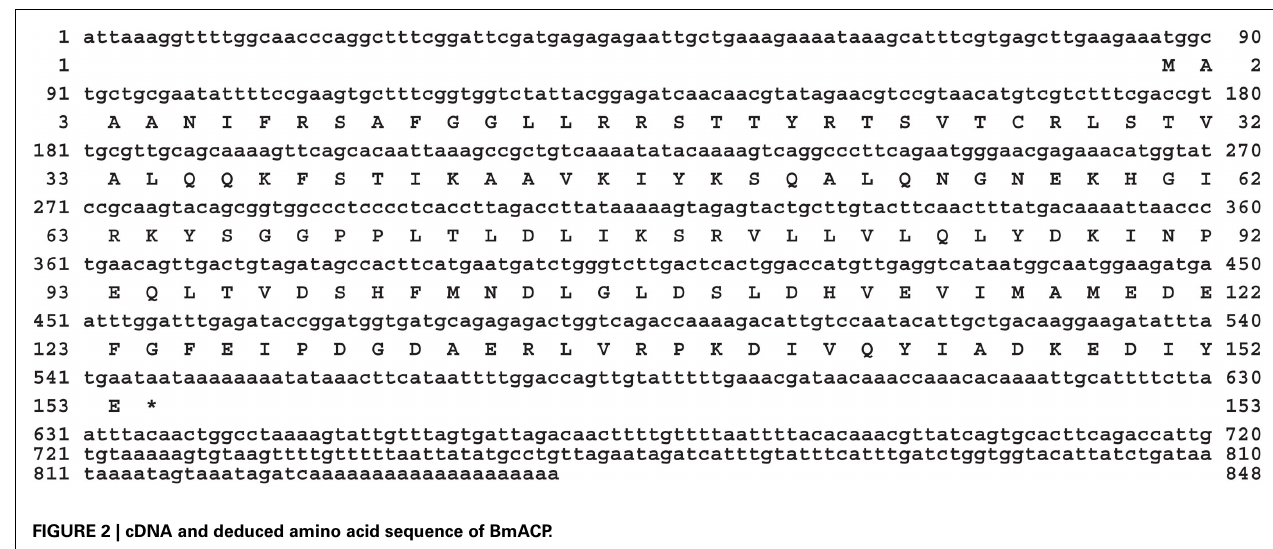
FIGURE 2 | cDNA and deduced amino acid sequence of